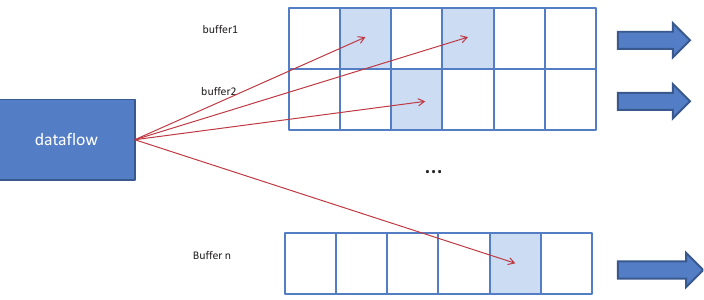
Figure 8. Dataflow gate structure. Buffer stores incomplete results. When the buffer is saturated, it outputs the entire result. When there is data duplication, it produces coverage in the buffer, avoiding duplicated